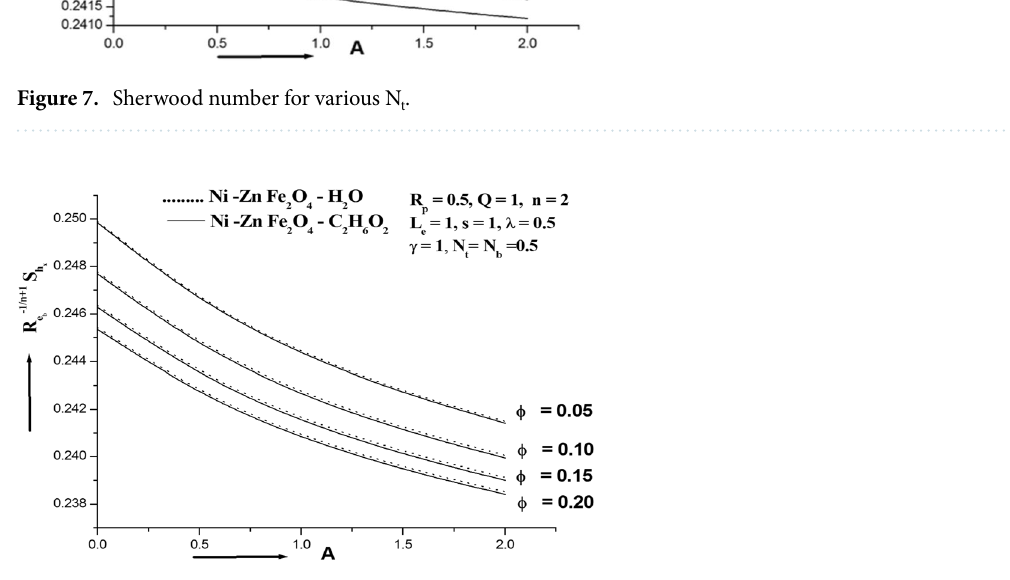
Figure 8. Sherwood number for various ϕ